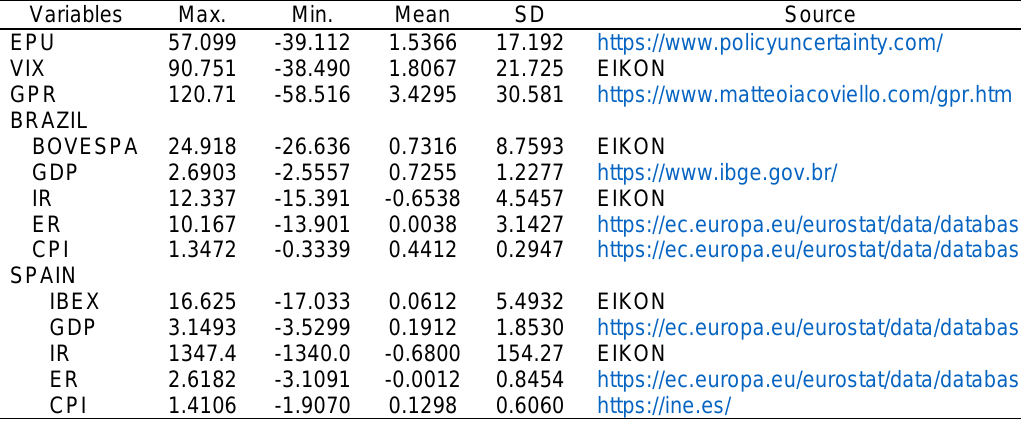
Table 1. Descriptive statistics and data